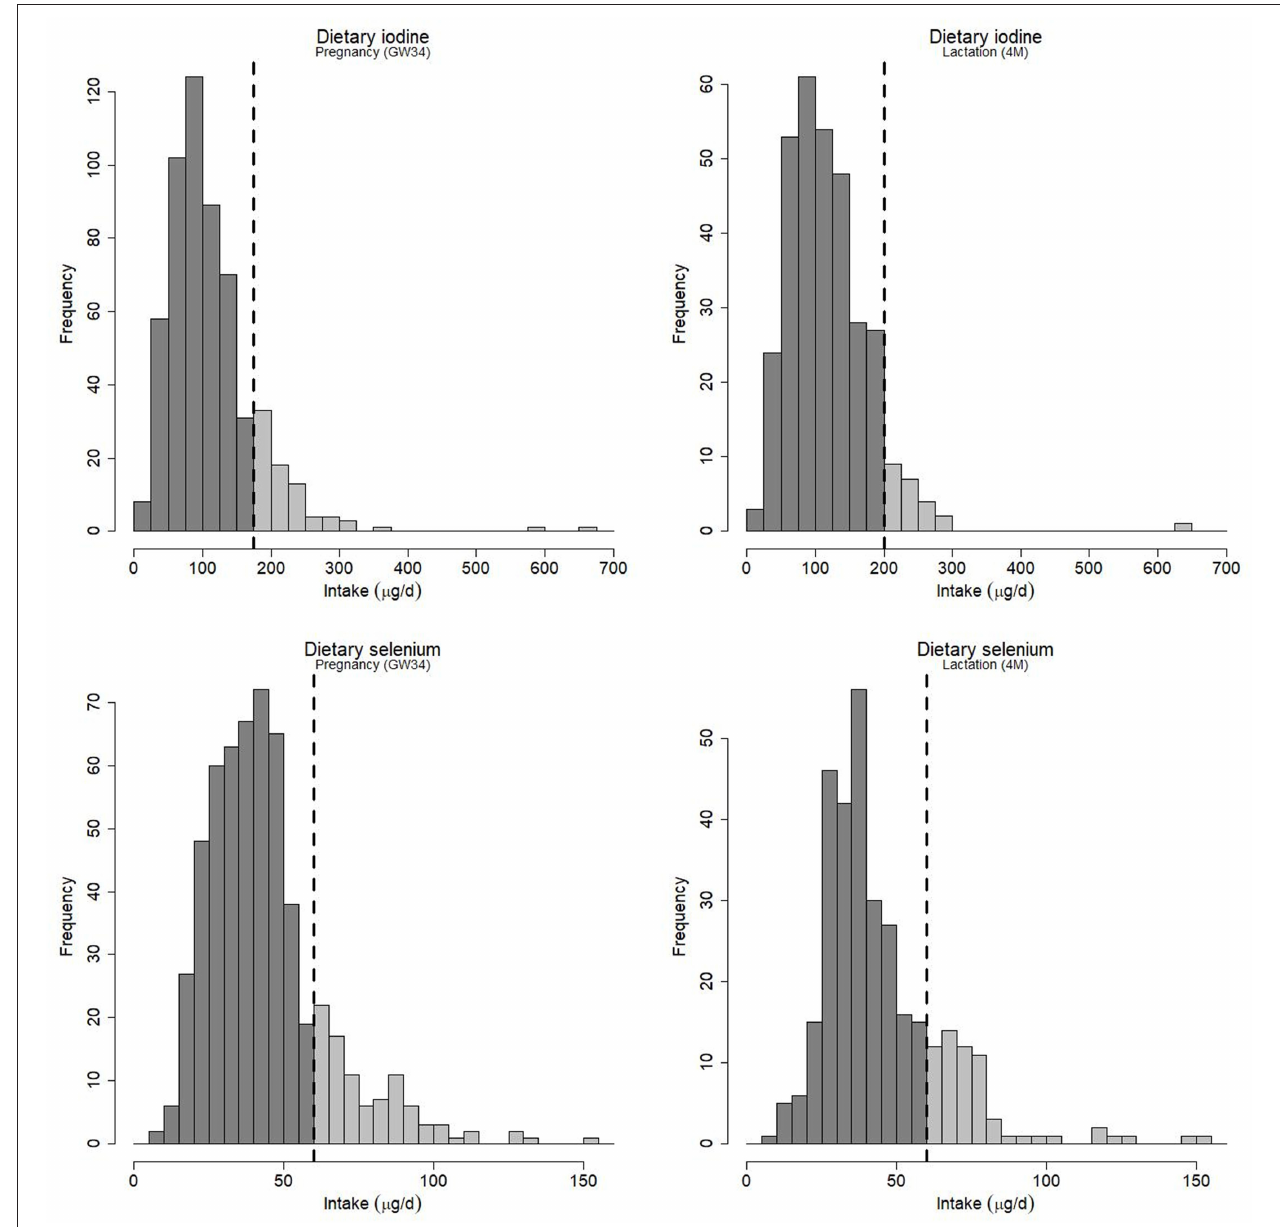
FIGURE 2 | Estimated maternal intake of iodine and selenium from dietary sources during gestational week 34 (GW34) and during lactation at 4 months postpartum (4M). Intake from supplements is not included. The vertical dashed line represents the recommended daily intake for pregnant and lactating women as given by the Nordic Council of Ministers